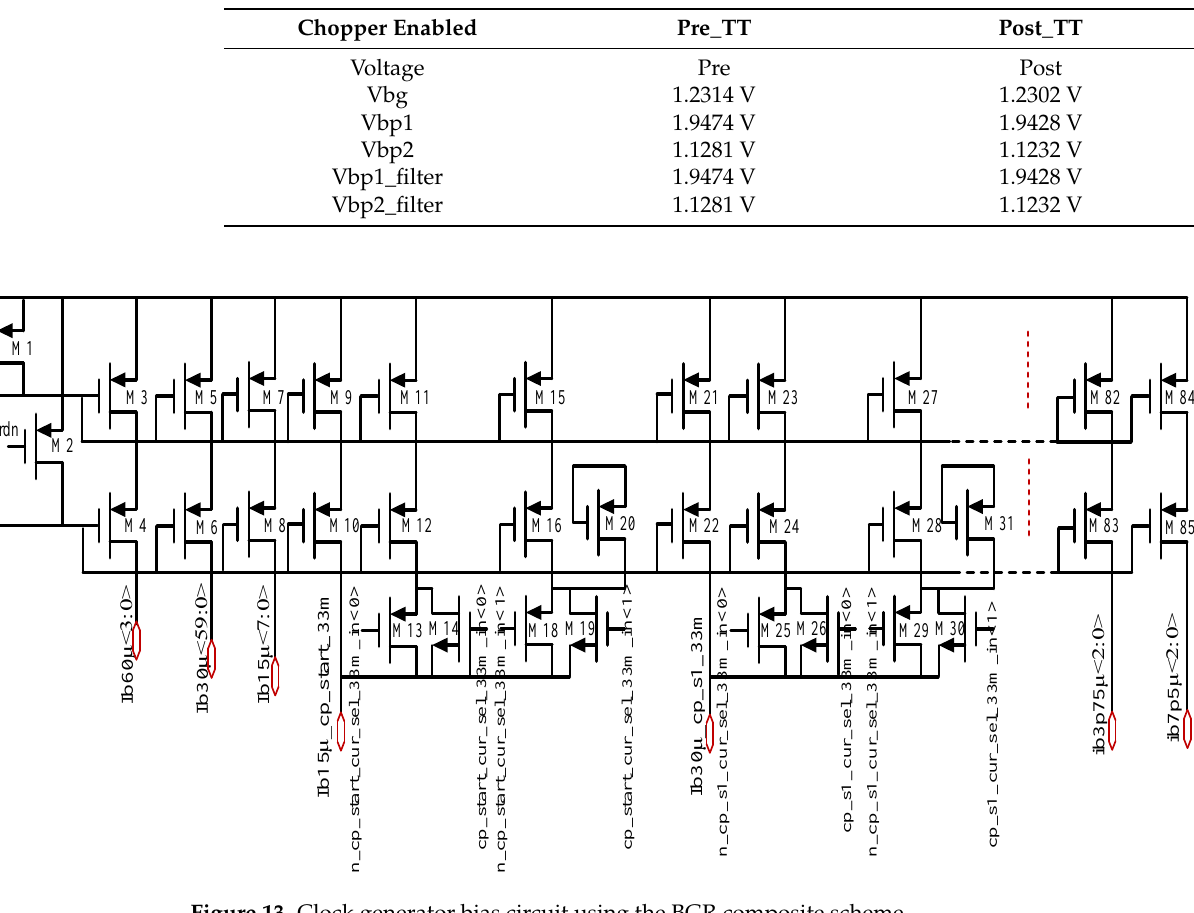
Figure 13. Clock generator bias circuit using the BGR composite scheme. Table 5. Summary of bias circuit current pre-simulation analysis.